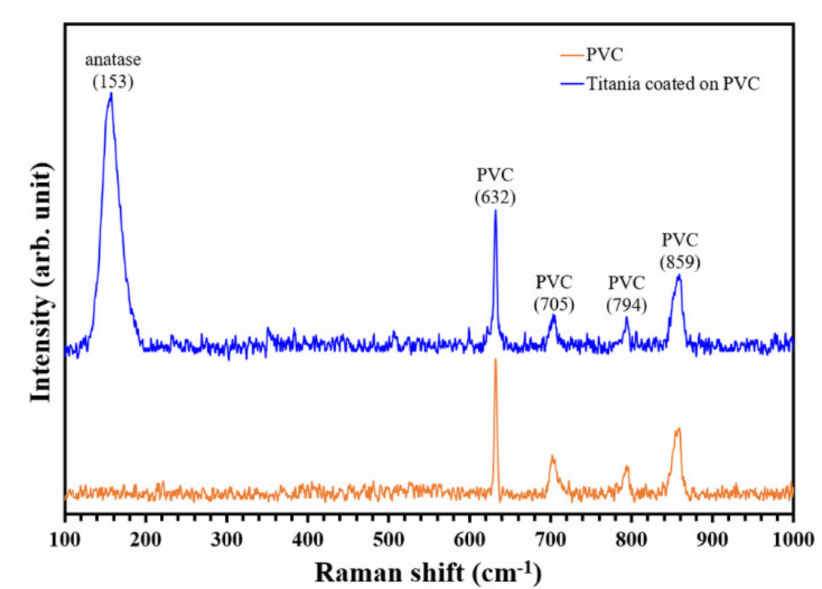
Figure 5. Quantification of phase content in TiO 2 thin film by Raman spectra.